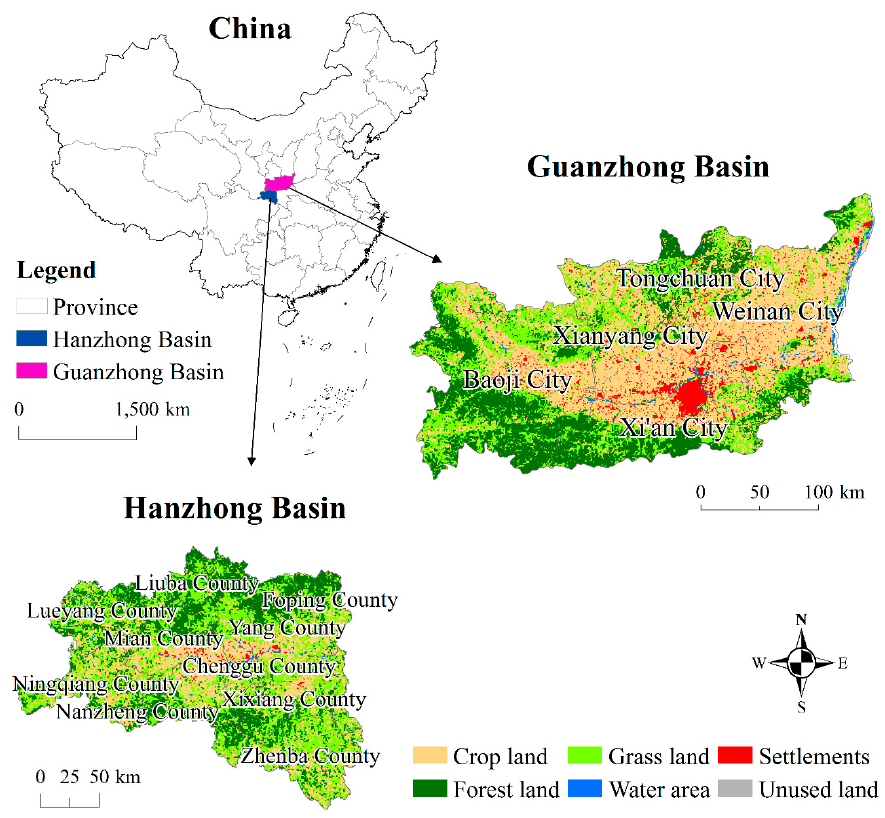
Figure 1. The geographical location and land use types of study areas in 2018.